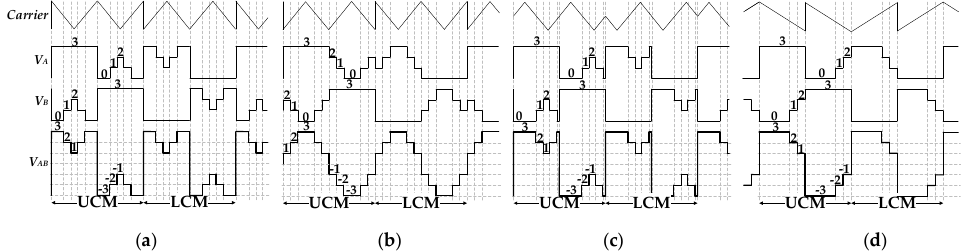
Figure 15. Four typical V leg waveforms depending on the carrier wave shape: ( a ) middle, ( b ) edge, ( c ) rear, and ( d ) end sag types.